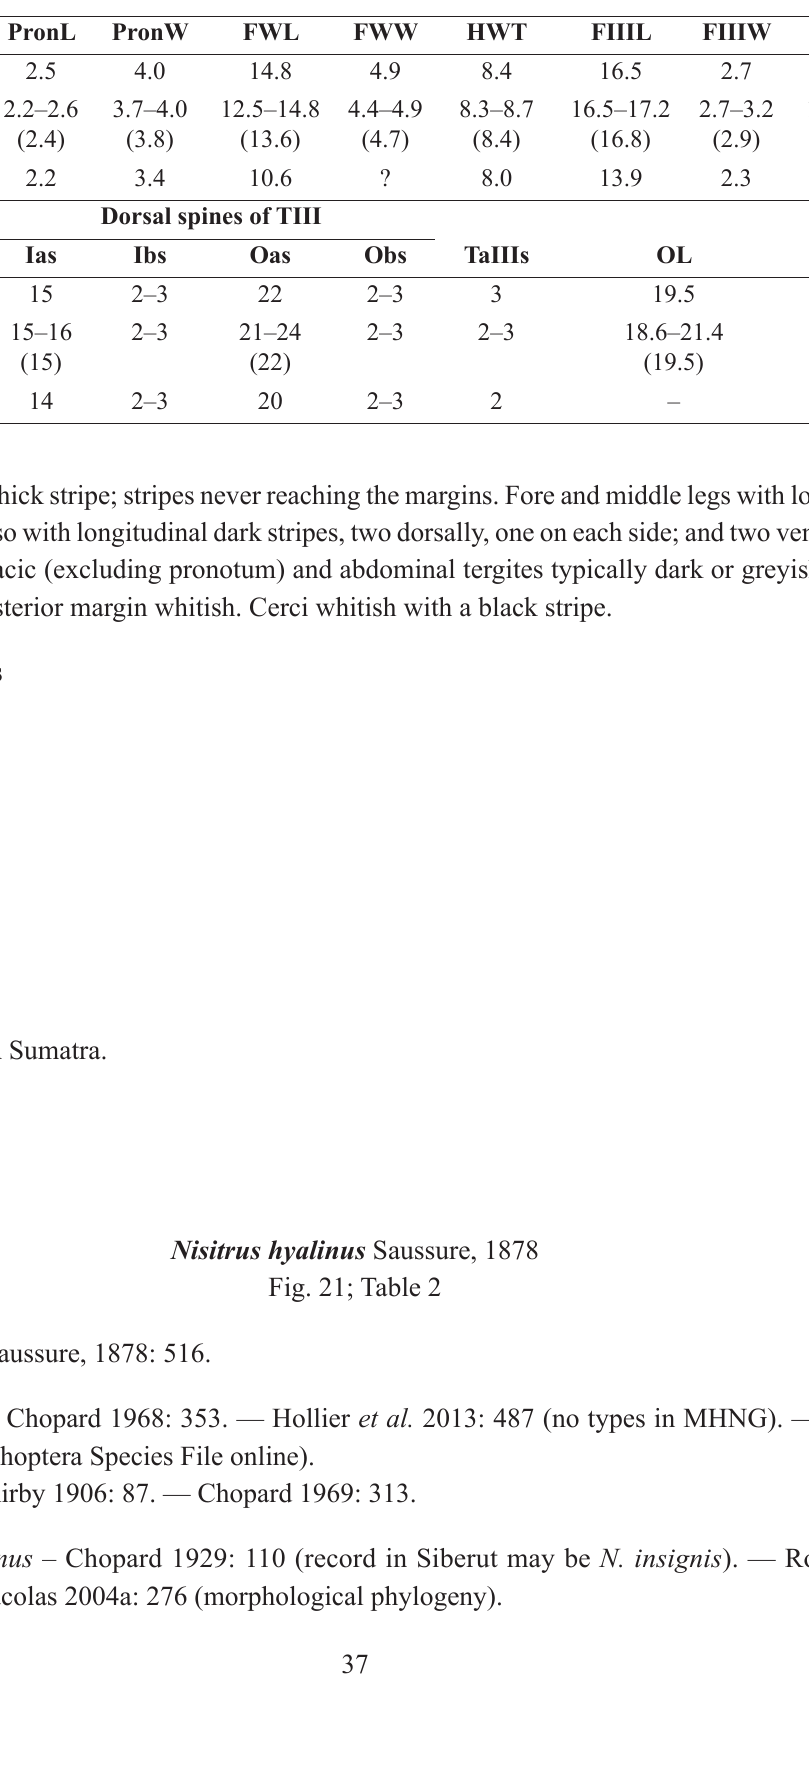
Table 6. Measurements of Nisitrus hughtani Robillard & Tan sp. nov. (in mm, means in